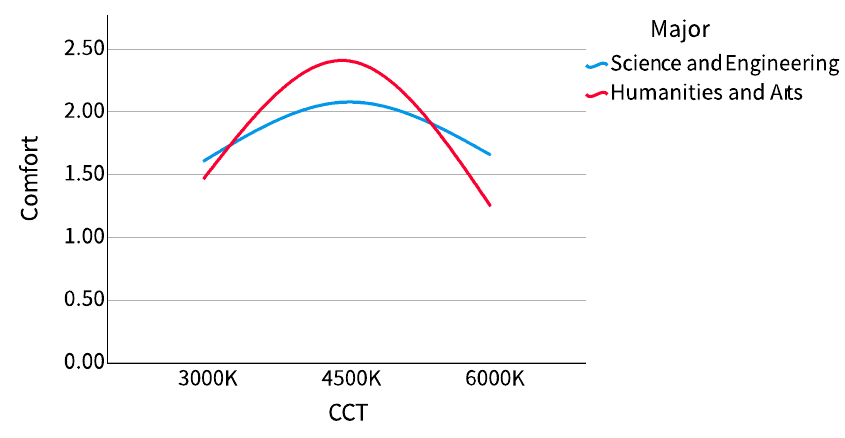
Figure 11. Comfort score line chart